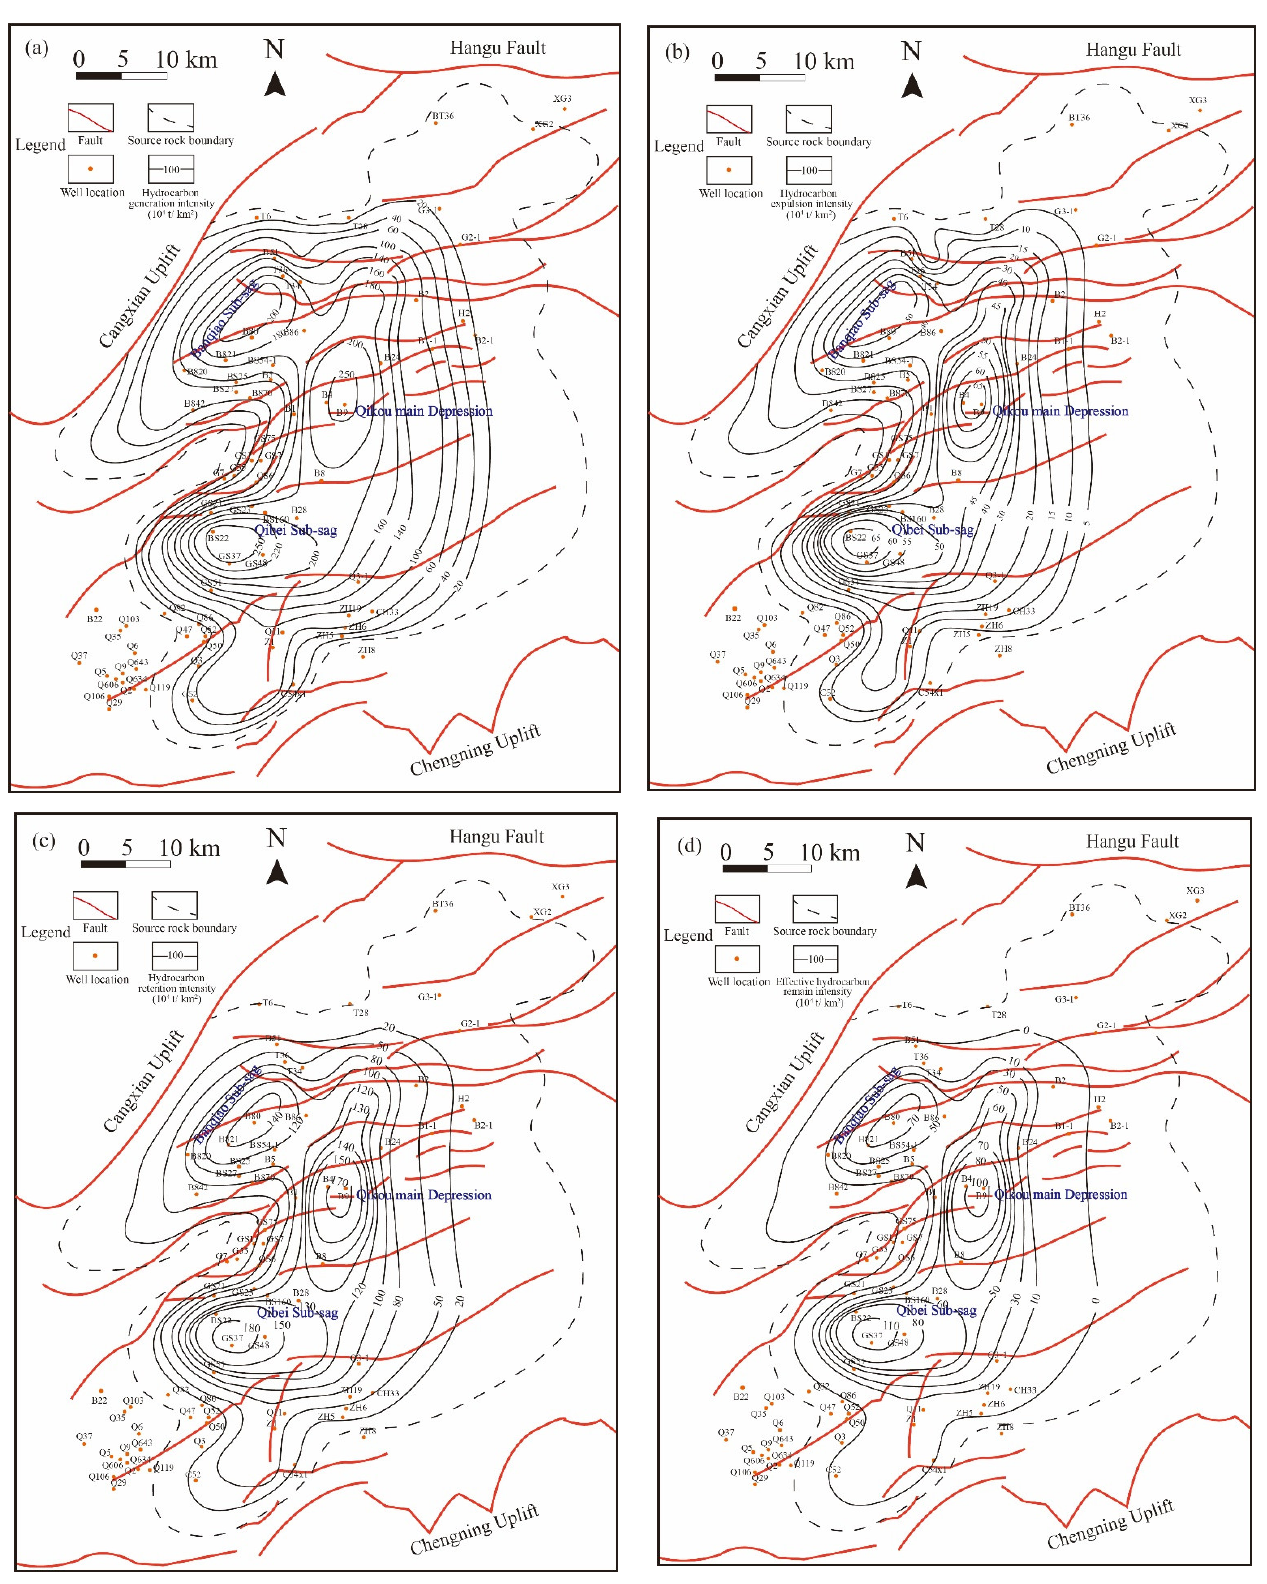
Figure 10. Generated and expelled HC intensities of Mbr 3 source rocks; ( a ) Generation HC intensity (I g ); ( b ) Expulsion HC intensity (I e ); ( c ) Retention HC intensity (I r ); ( d ) Effective retention HC intensity (I re ).